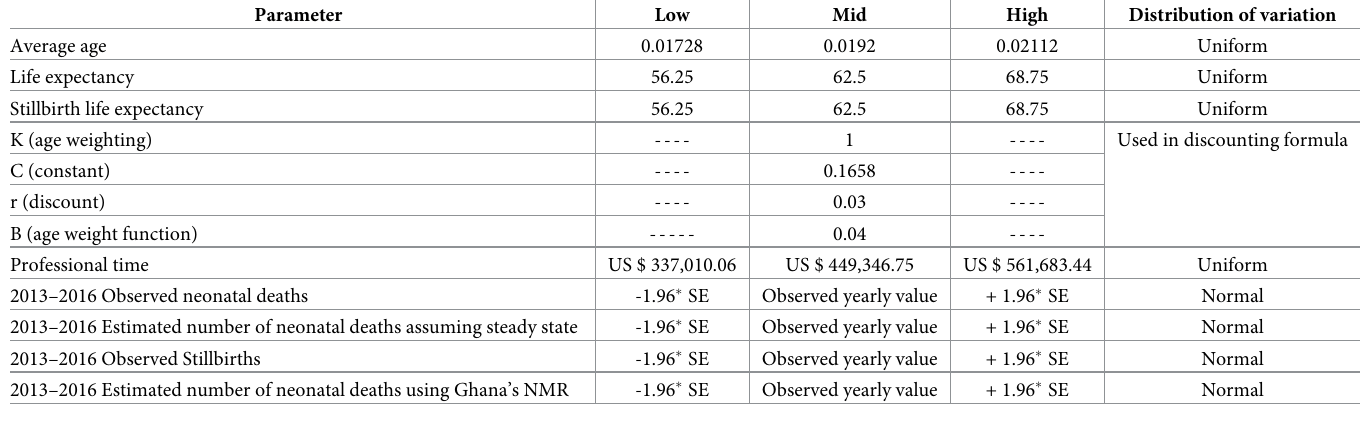
Table 4. Sensitivity analysis parameters.